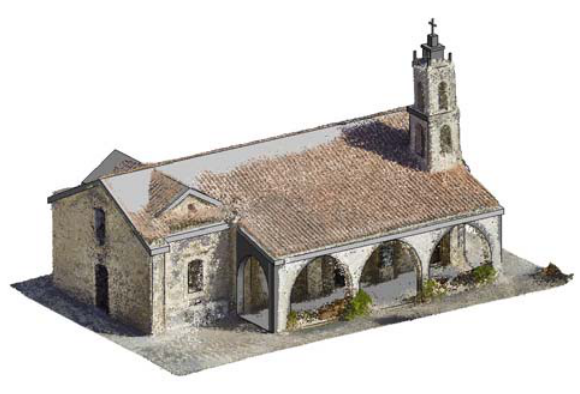
Figure 8. Point cloud with BIM model